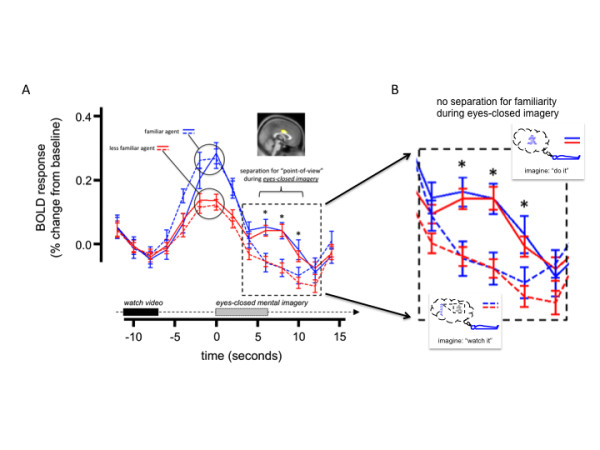
Middle cingulate cortex differentiates perspective taking responses during eyes-closed imagery. (A) Time-series of BOLD response in middle cingulate cortex during structured imagery task. (Inset: mask used in time-series analysis.) Mean BOLD response (% signal change from baseline) along the vertical axis; time (s) along the horizontal axis. Plotted: mean response of the middle cingulate cortex (MCC) ± standard error about the mean for motor-imagery trials (solid lines) and visual-imagery trials (dashed lines) for expertise-congruent conditions (blue lines) and expertise-incongruent trials (red lines). Note: the MCC responds during motor-imagery trials, but not during visual-imagery trials (solid lines vs. dashed lines, time-points +4 s to +12 s, see dashed box), and the MCC does not differentiate expertise-congruent trials from expertise-incongruent trials during eyes-closed visual or motor imagery (blue lines vs. red lines, time-points +4 s to +12 s). Asterisks: p < 0.05, (one-tailed t-test, n = 81 subjects: ‘do it’ > ‘watch it’ collapsed over congruency conditions). (B) Middle cingulate response during eyes-closed imagery. Familiarity with subject and action (for example, athletic expertise congruency) does not separate MCC response during eyes-closed imagery; however, first-person perspective-taking does.